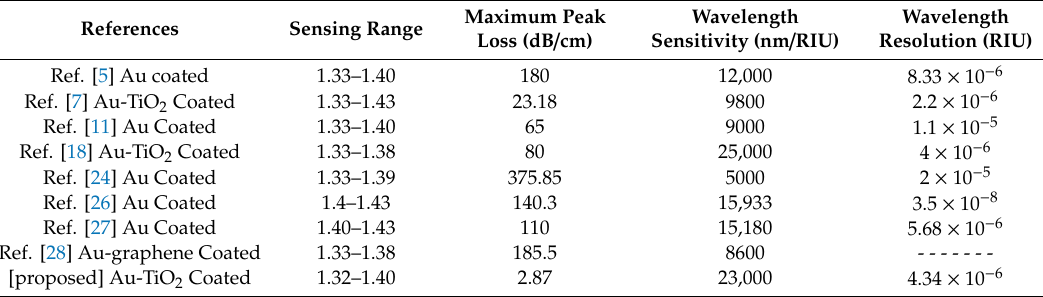
Table 2. Performance comparison with the previously reported PCF-SPR